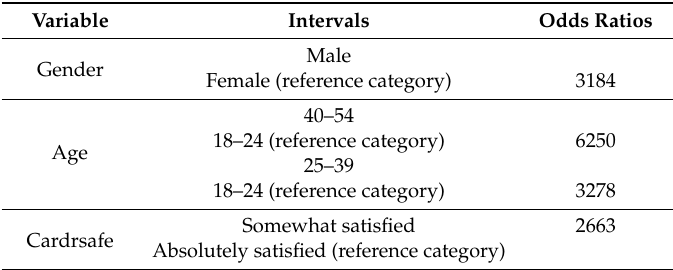
Table 2. Odds ratios results for the private car model.